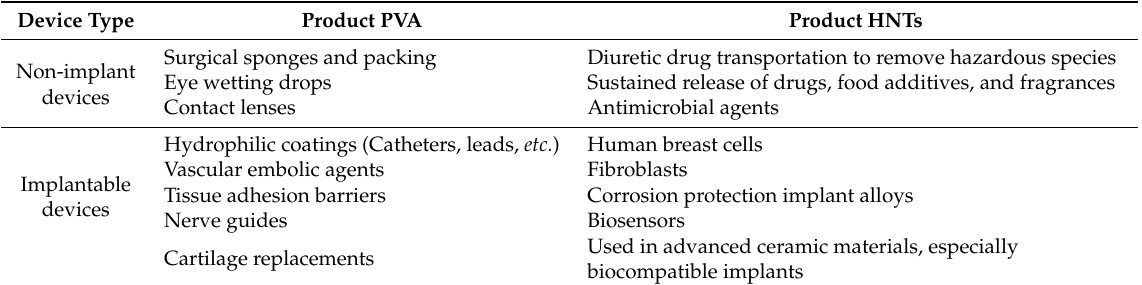
Table 2. Uses of PVA and HNTs in non-implant and implantable devices